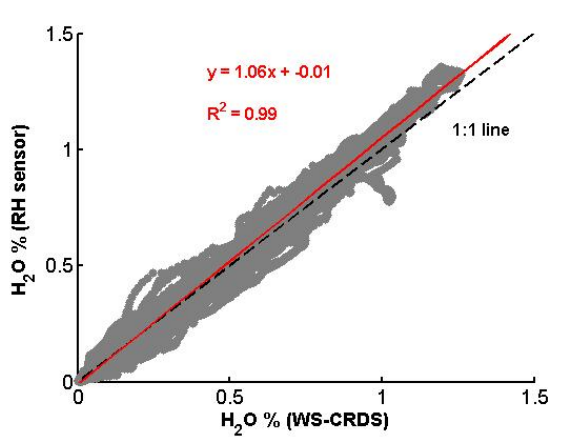
Fig. 13. Comparison of CRDS H 2 O with values calculated from the temperature and relative humidity sensor over the entire 2011 season. Red line shows the linear fit to the data, while the black dashed line indicates the 1:1